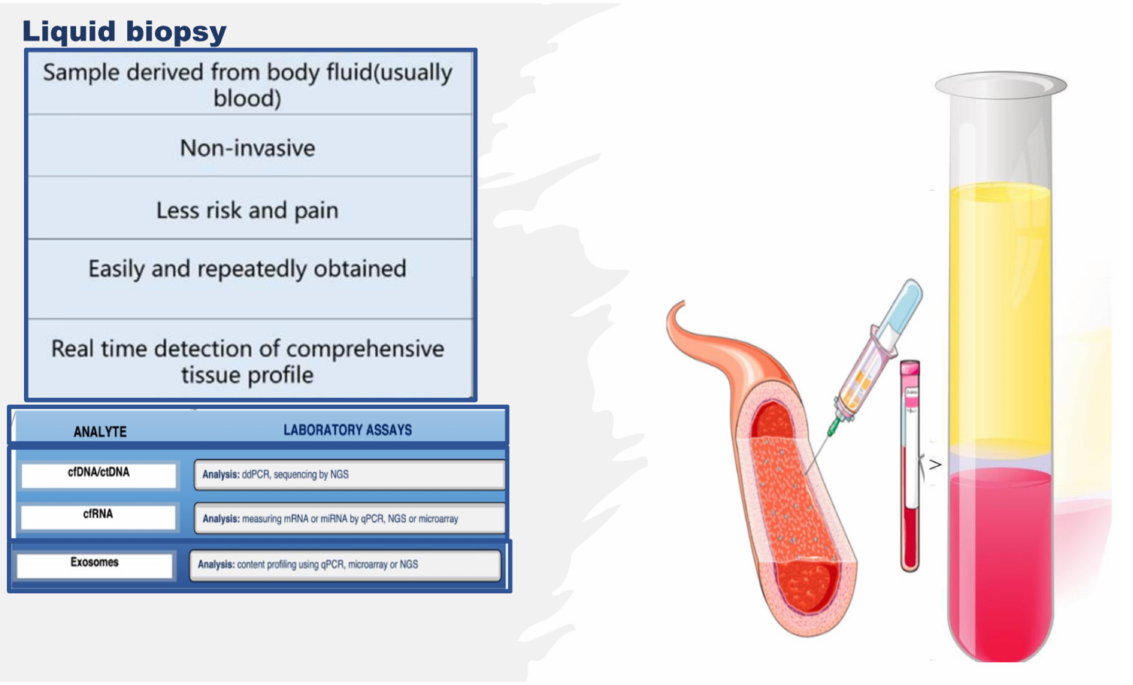
Figure 5. Liquid biopsy, describing some components and laboratory analysis techniques. Liquid biopsy involves the collection and analysis of diverse components from peripheral blood samples, including cell-free nucleic acids (cfDNA/ctDNA and cfRNA) and exosomes. cfDNA: circulating free DNA, ctDNA: circulating tumor DNA, cfRNA: cell-free RNA, CTCs: circulating tumor cells, TEPs: tumor-educated platelets, NGS: next-generation sequencing, qPCR: quantitative polymerase chain